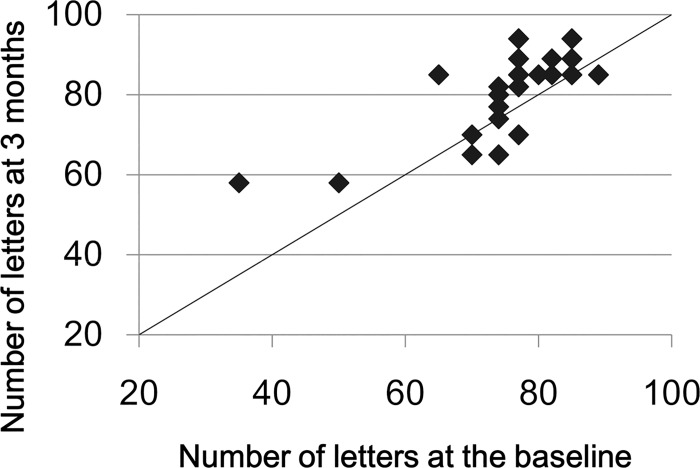
Scattered plots showing the associations between BCVA at the baseline and that at 3 months.No eye was worsened ≥10 letters at 3 months compared with that at baseline. The data of 7 eyes were overlapped each other in this scattered plots.